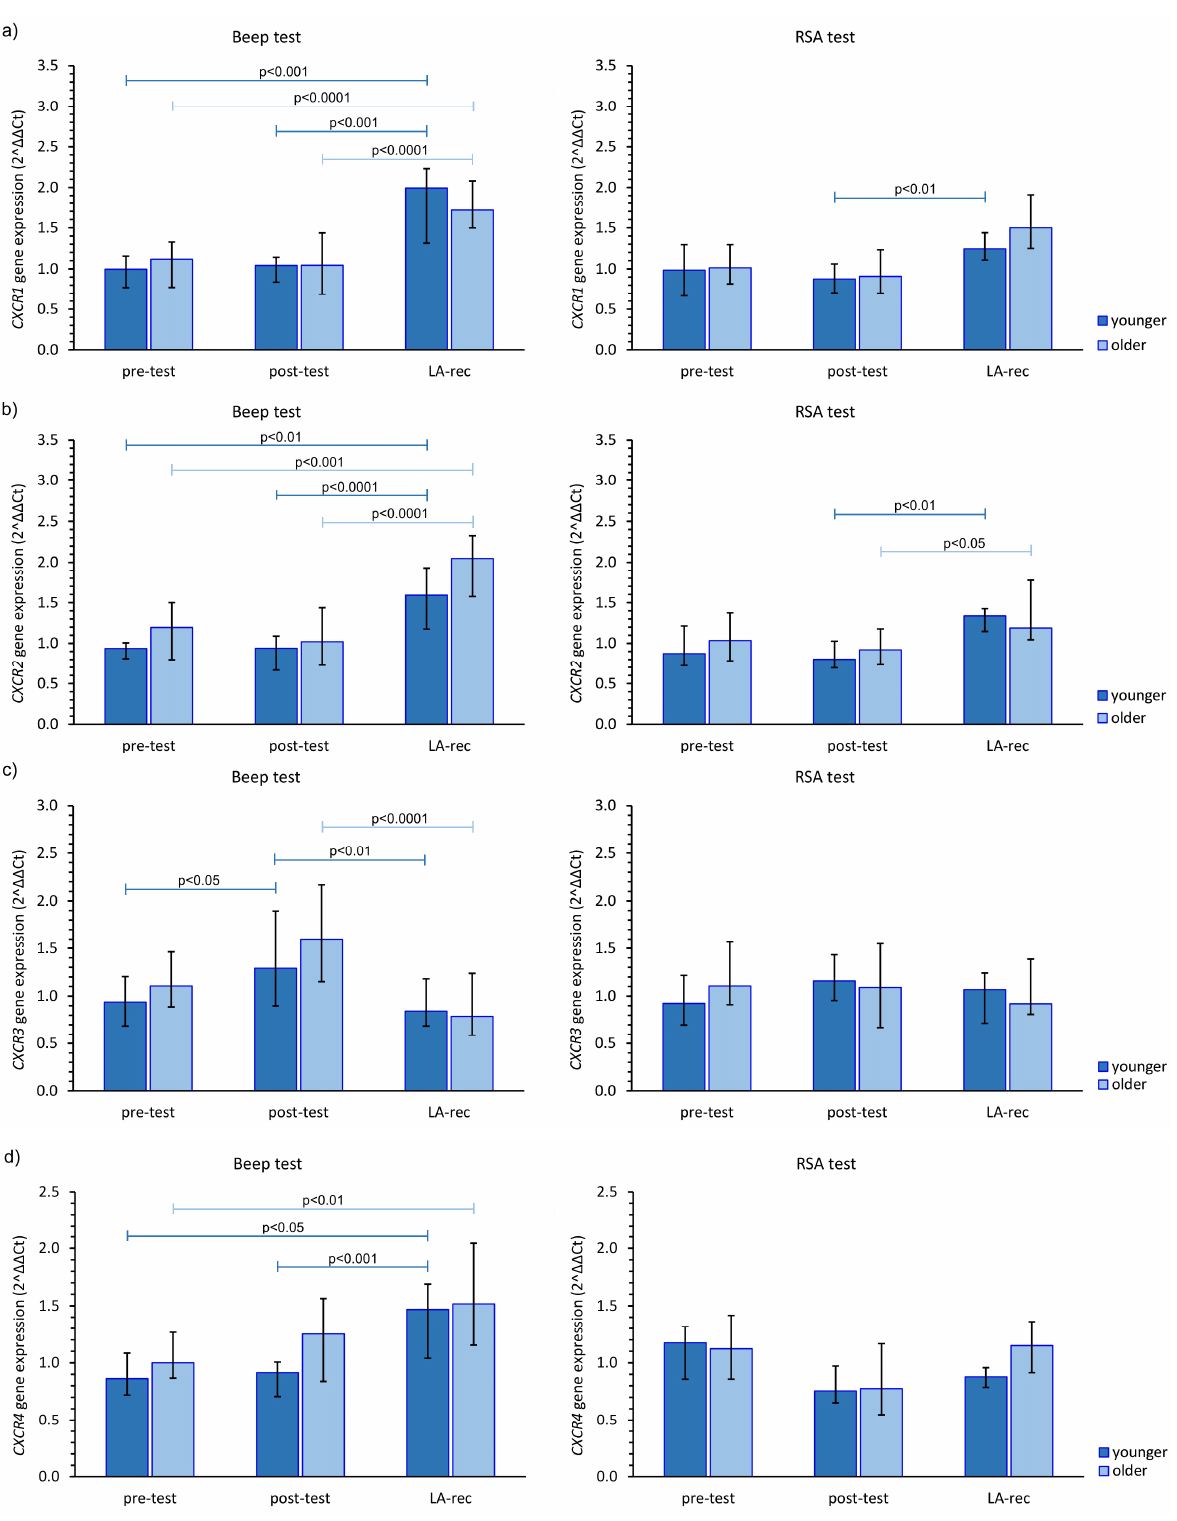
Figure 3. The impact of aerobic (Beep test) and anaerobic (RSA test) effort on the relative expression of studied genes encoding ( a ) CXCR1 , ( b ) CXCR2 , ( c ) CXCR3 , ( d ) CXCR4 . The figures present median (interquartile range) values. Significance levels of differences observed between analyzed time points (pre-test vs. post-test vs. LA-rec) were assessed using Friedman’s analysis of variance for repeated measures followed by post hoc Dunn’s test with Bonferroni correction.